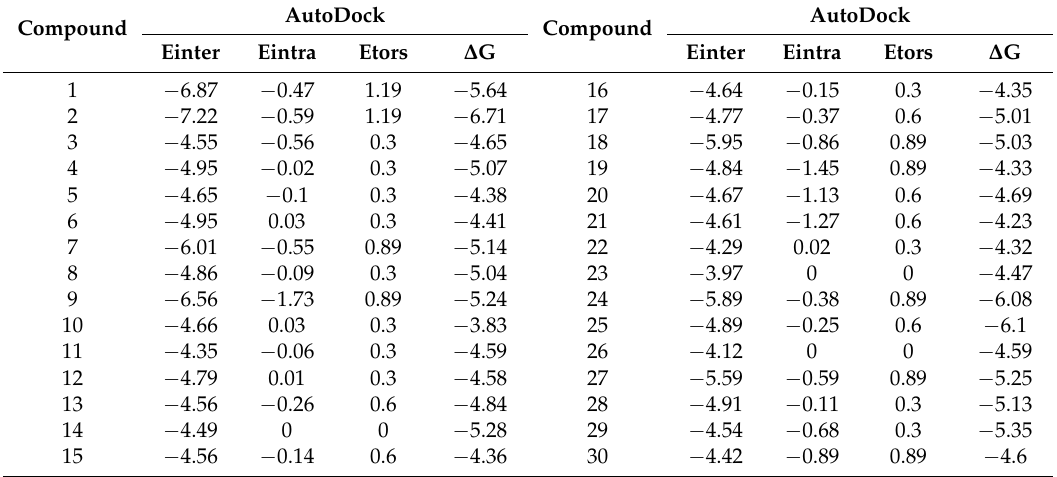
Table 1. Docking results of coumarins with Ca 2+ -ATPase 1 gene of Tetranychus cinnabarinus ( TcPMCA1